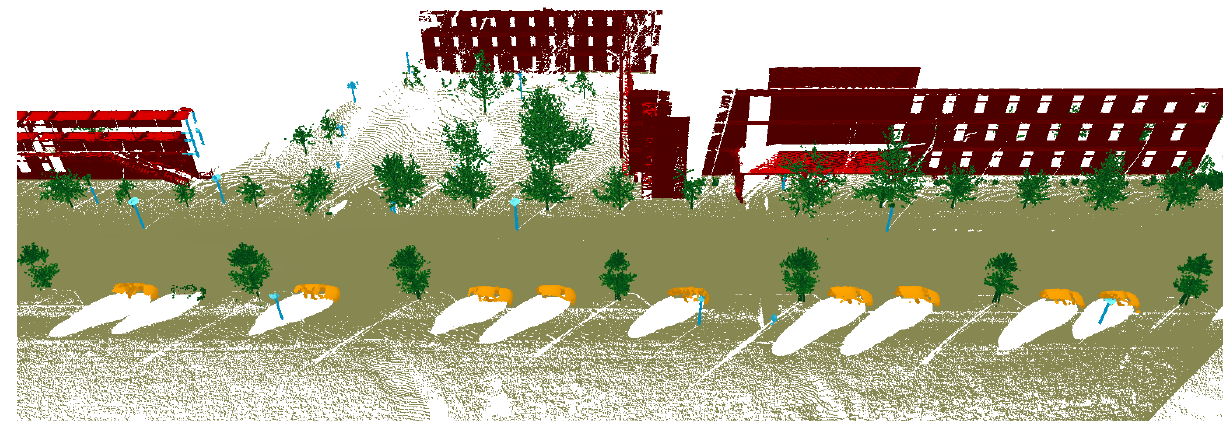
Figure 1. Point cloud colored based on semantic class: Ground (brown), vegetation (green), buildings (red), vehicles (orange), pole-like structures